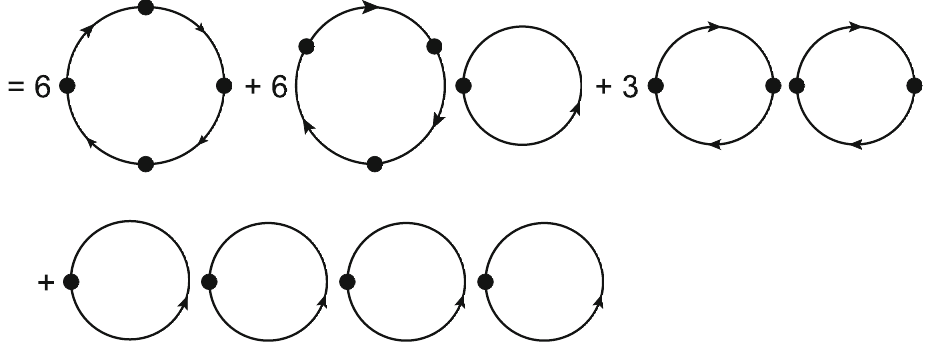
(cid:3) (cid:2) N 4 . The point represents the vertex and the line represents the quark